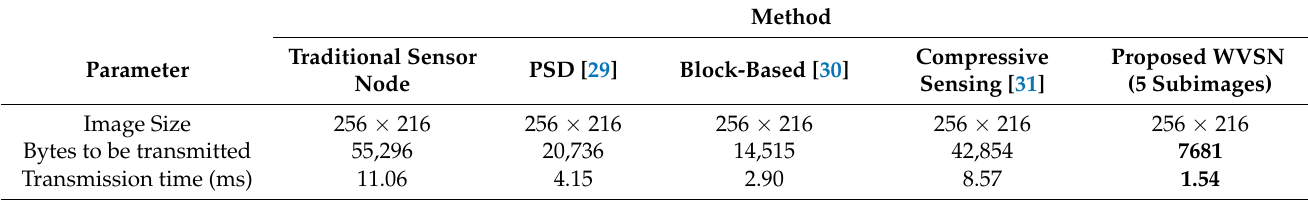
Table 2. Bandwidth utilization comparison of WVSN